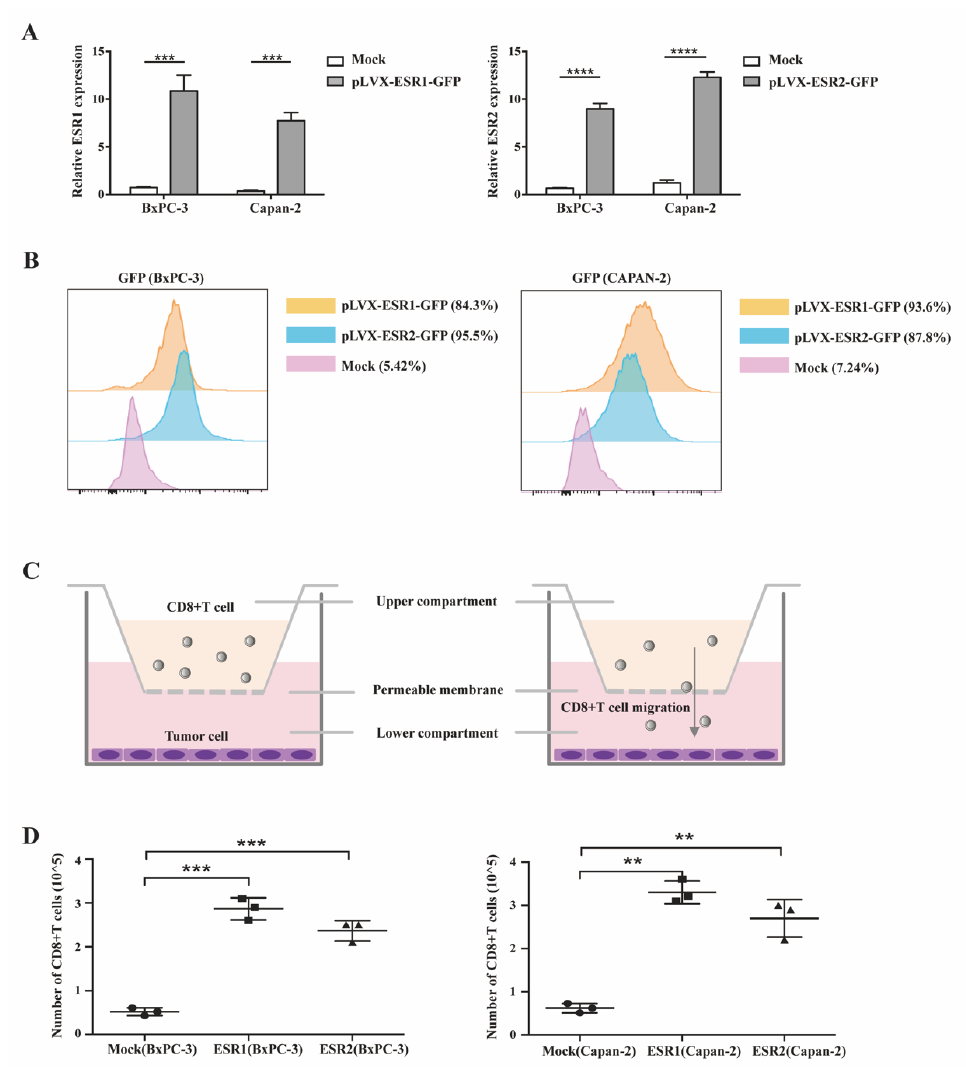
Figure 5. Immune cell chemotaxis assay. ( A ) Expression efficiency of ESR1 and ESR2 in PAAD tumor cells detected by qRT-PCR; *** p < 0.001, **** p < 0.0001. ( B ) Efficiency of ESR1 or ESR2 (GFP) overexpression in BxPC-3 or Capan-2 cells detected by flow cytometry. ( C ) The schematic diagram of chemotaxis assay. ( D ) The number of CD8 + T-cells in the supernatant of BxPC-3 or Capan-2 cells in chemotaxis assay; ** p < 0.01, *** p < 0.001.